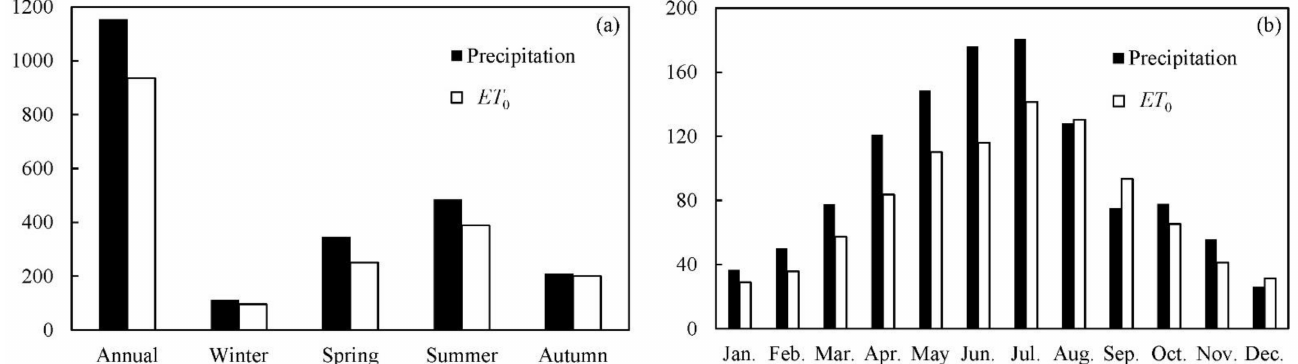
Figure 2. ( a ) showed the annual and seasonal mean precipitation and ET 0 in JHP from 1977 to 2018. ( b ) showed the average of precipitation and ET 0 of each month during the same